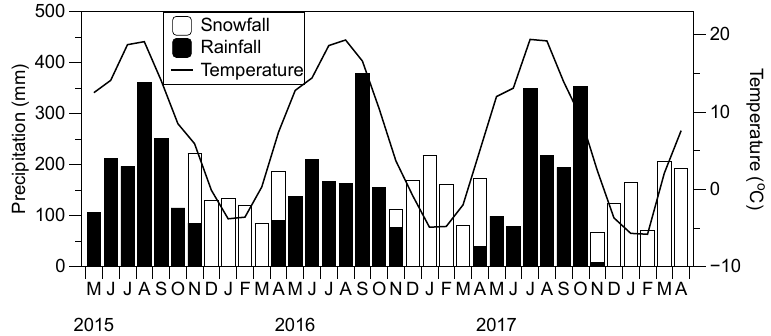
Figure 2. Precipitation (mm) and air temperature ( ◦ C) at the study site from May 2015 to April 2018. Data were obtained from the meteorological station at the Takayama Field Station.